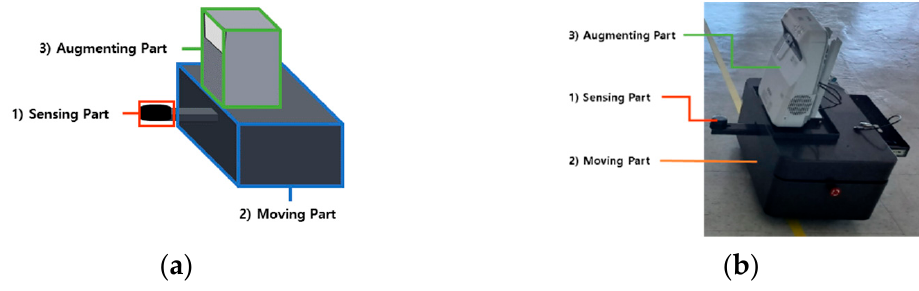
Figure 1. Proposed system: ( a ) concept of the system; ( b ) the photograph of the actual system.